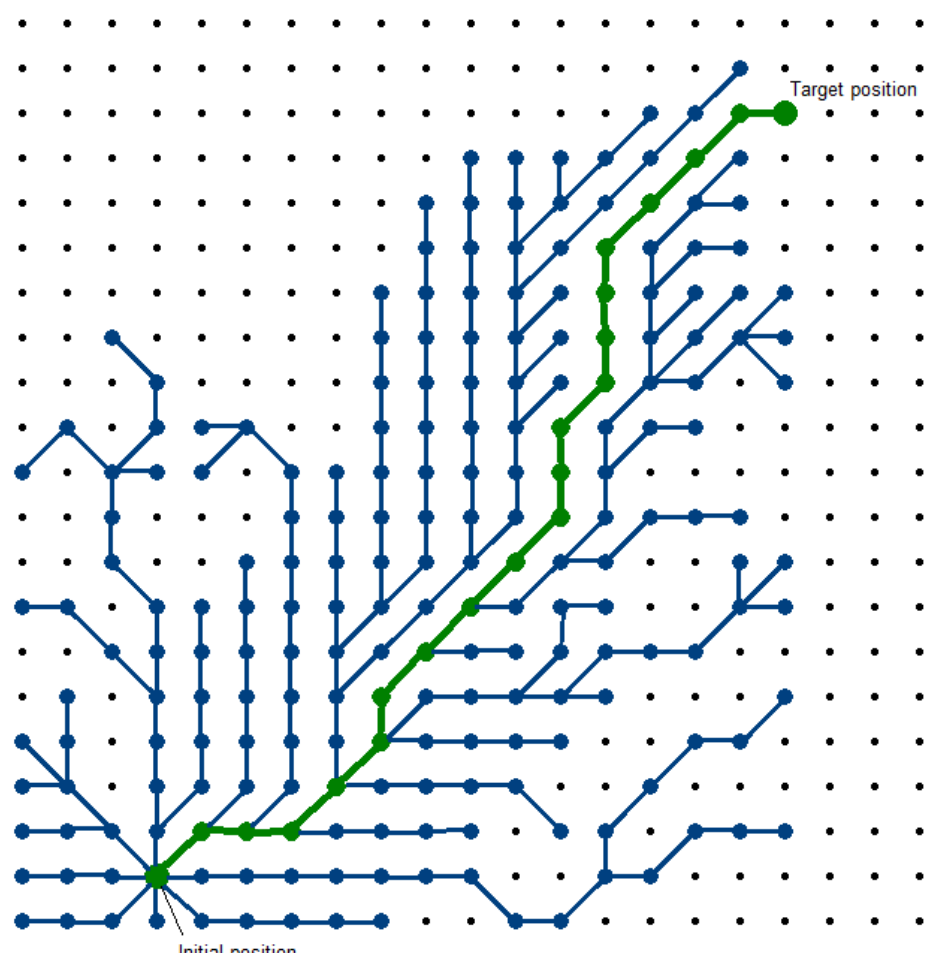
Figure 14. Illustration of the forward